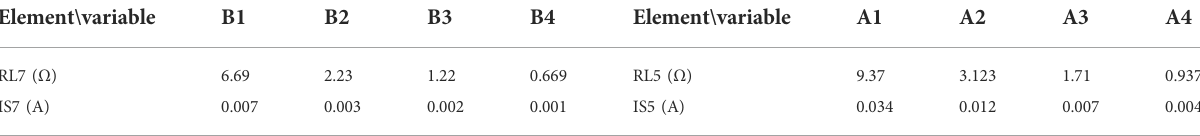
TABLE 4 Fifth- and seventh-order fi lter resistor values for different combinations.